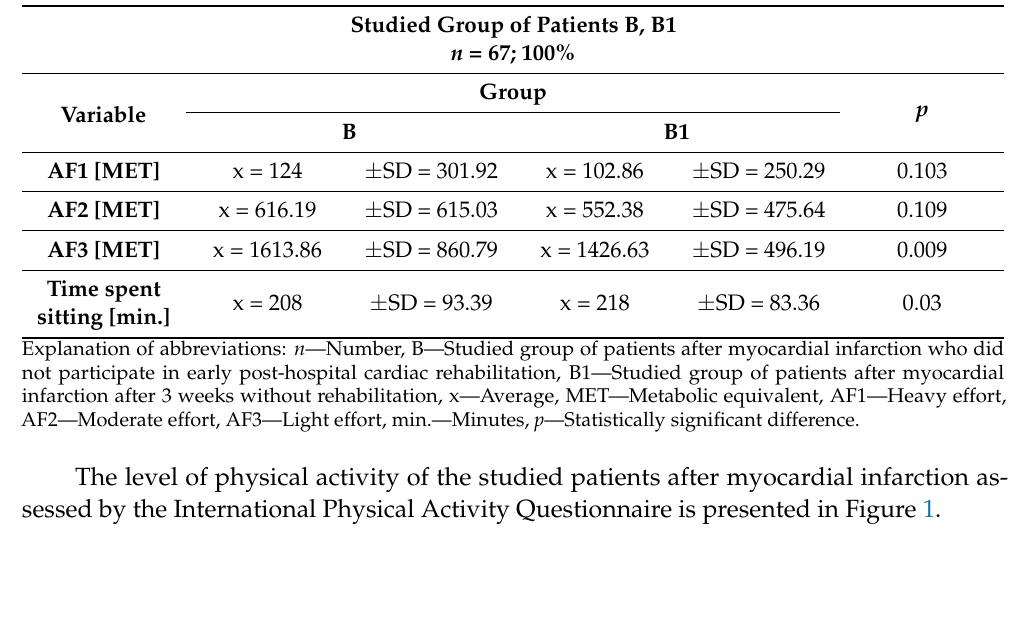
Table 4. Characteristics of the studied group of patients after myocardial infarction who did not par- ticipate in early post-hospital cardiac rehabilitation (B) and after 3 weeks without rehabilitation (B1), taking into account physical activity assessed by the International Physical Activity